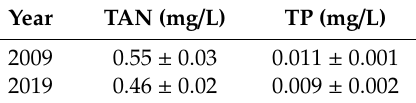
Table 2. Total ammonia nitrogen (TAN) and phosphorus (TP) budget in the lagoon basin outlet water (mean ± standard deviation).